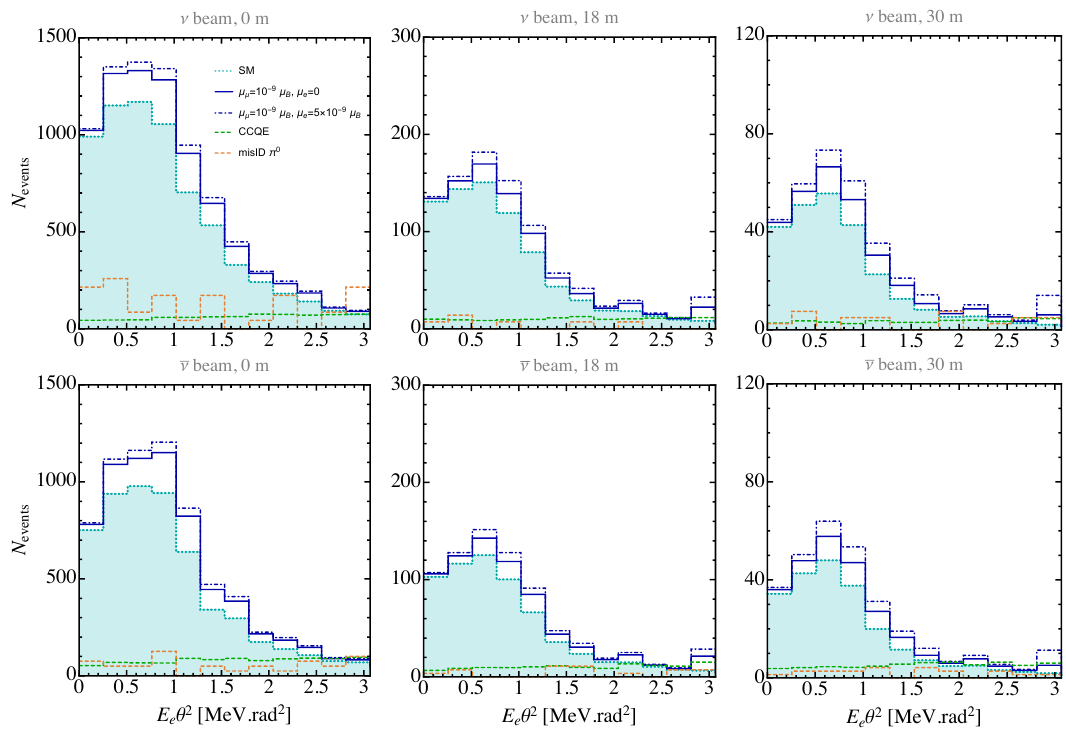
Figure 2 . Here we are plotting the event distributions, binned in the variable E e θ 2 , for ν -mode (top row) and ¯ ν -mode (bottom row) for on-axis (left column), 18 m off-axis (middle column), and 30 m off-axis (right column). The shaded cyan region represents the SM prediction, while the dashed light blue and dashed orange represent the CCQE and mis-identified π 0 backgrounds. The dark blue solid (dark blue dot-dashed) include the contributions the magnetic moment with µ µ = 10 − 9 µ B ( µ µ = 10 − 9 µ B and µ e = 5 × 10 − 9 µ B